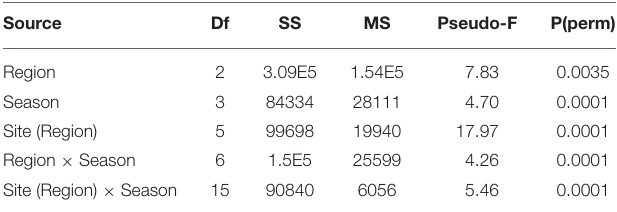
TABLE 2 | Results of the three factor partially nested PERMANOVA analyses assessing differences between regions, seasons and sites (within regions) in benthic community